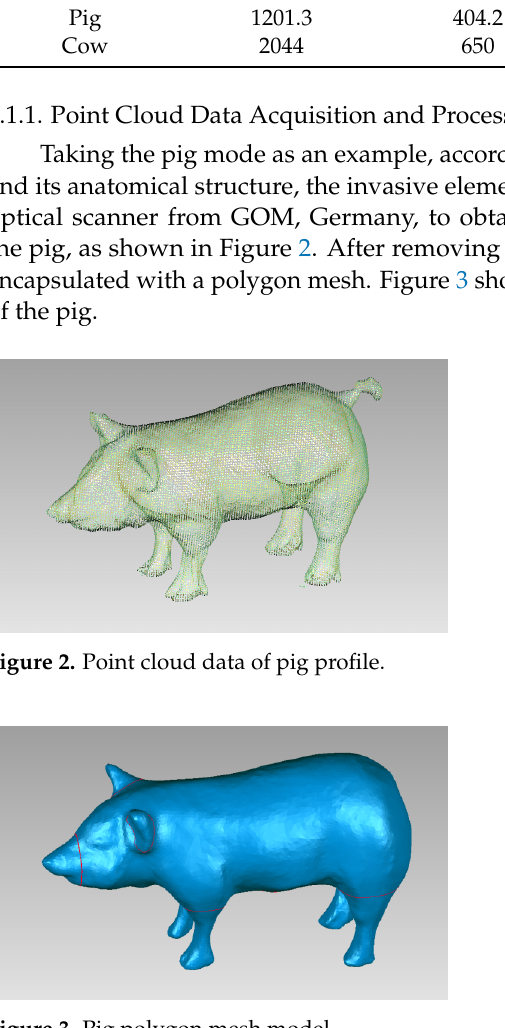
Figure 3. Pig polygon mesh